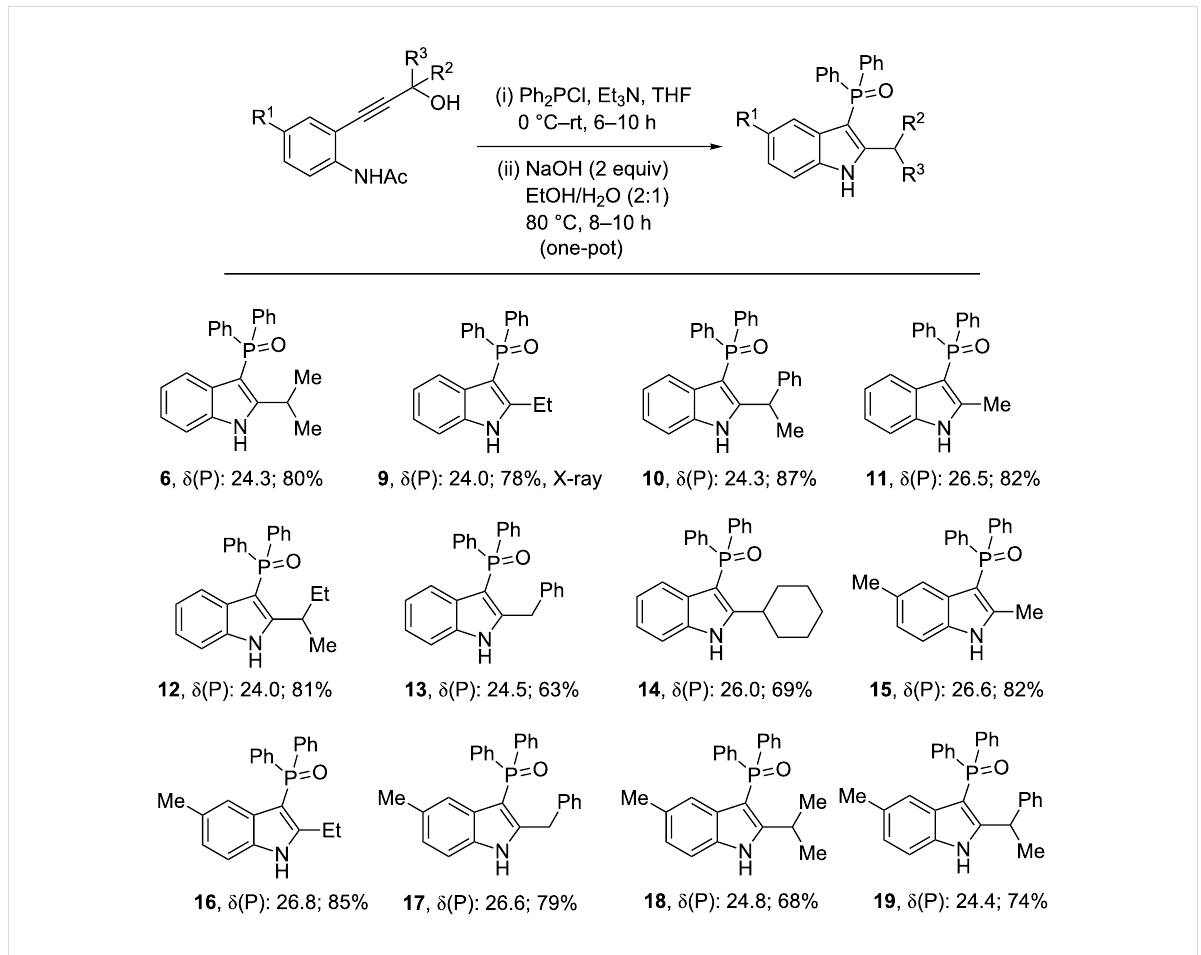
Scheme 5: One-pot preparation of substituted phosphinoylindoles 6 and 9–19 from functionalized alcohols.